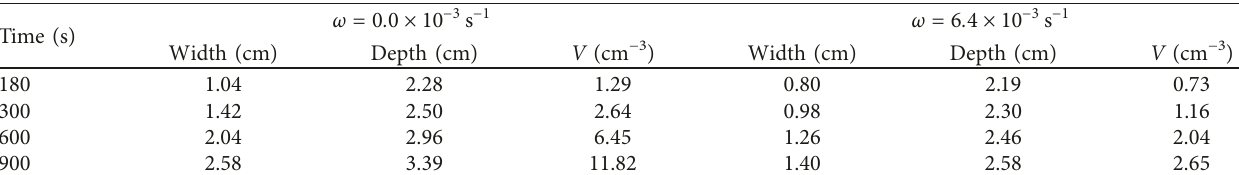
3 s 1 ) and fully perfused ( ω 0 . 0 10 (cid:31) × − −